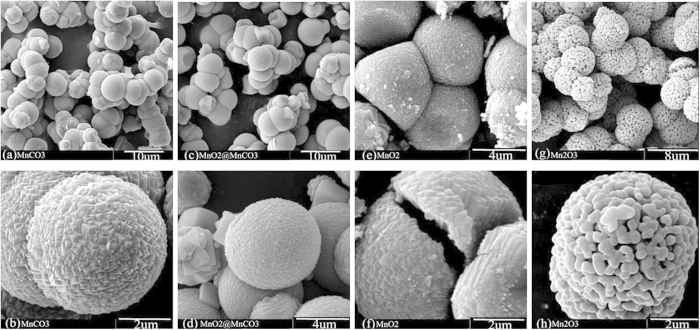
SEM micrographs of materials obtained during the procedure of synthesizing precursors:(a,b) MnCO3 precipitate before calcination, (c,d) MnO2/MnCO3 composite obtained after calcinating the precipitate at 350 °C, (e,f) MnO2 obtained after acid-washing the MnO2/MnCO3 mixture and (g,h) Mn2O3 obtained after calcinating the MnCO3 precipitate at 800 °C.